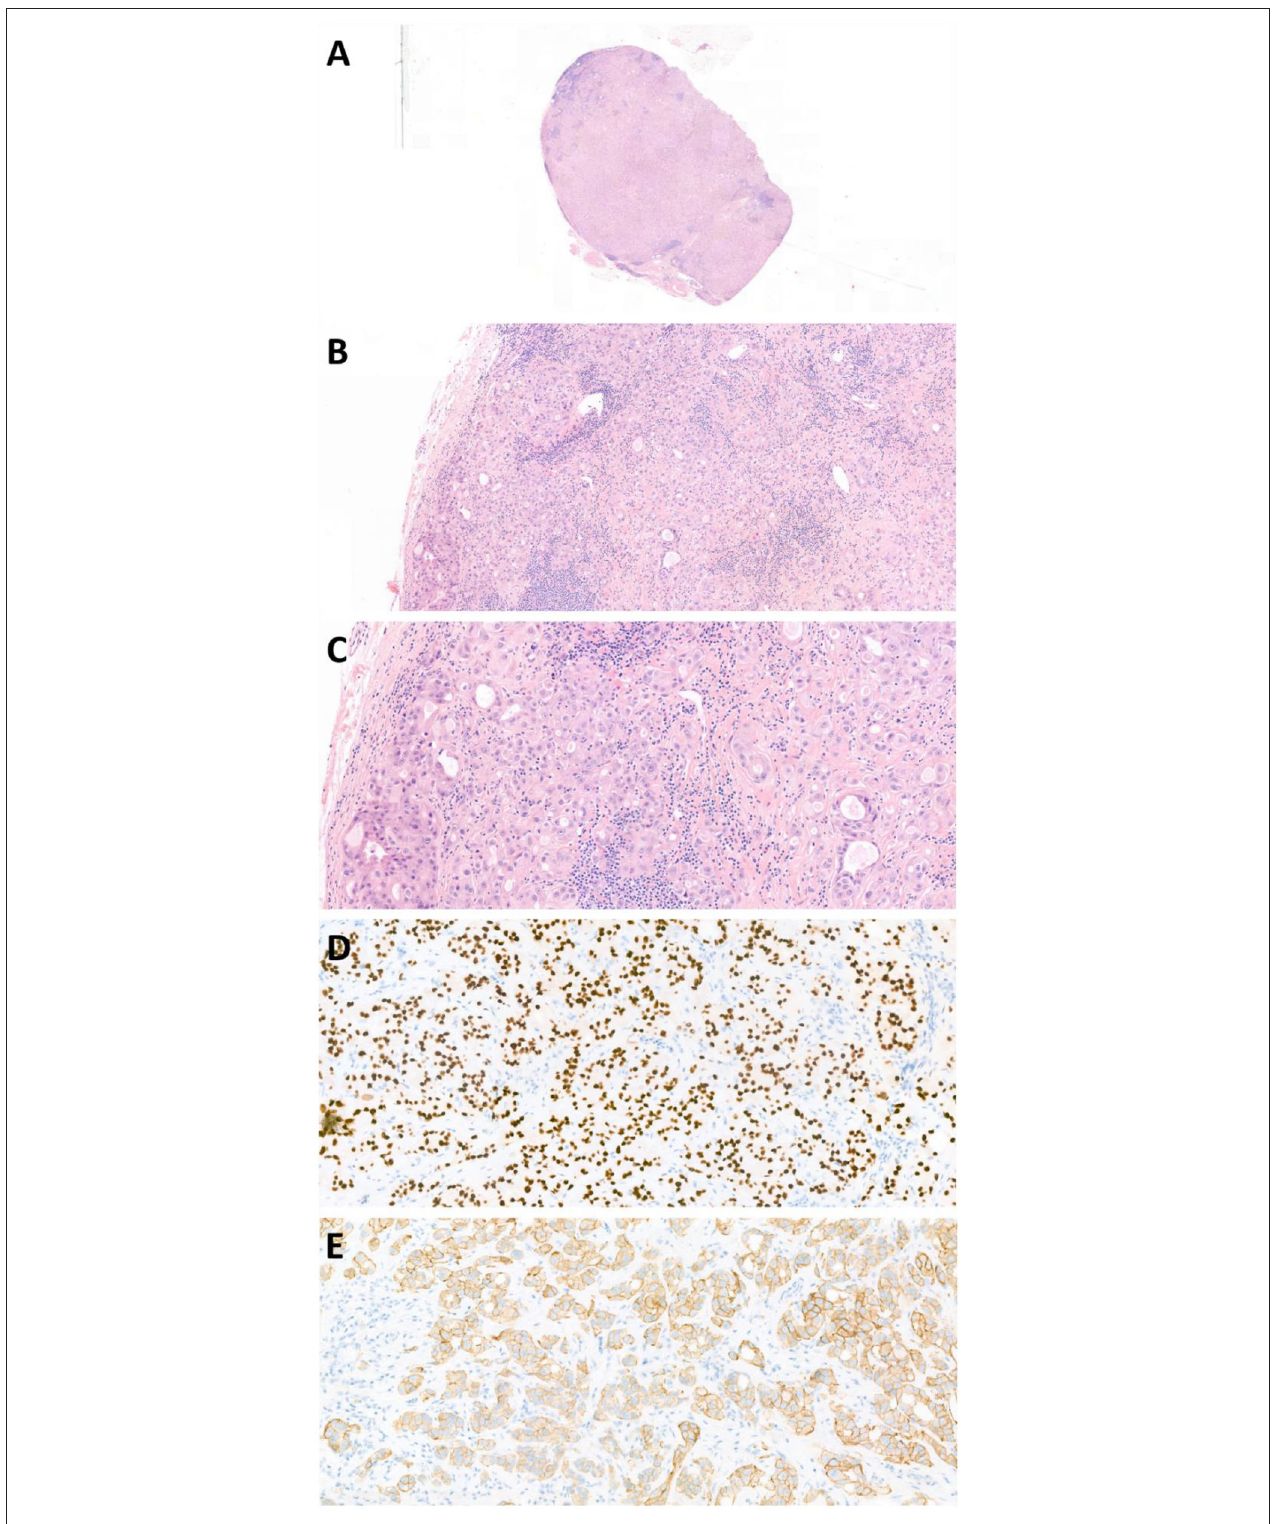
FIGURE 2 | Photomicrographs of case report 1: cervical lymph node containing an SDC metastasis. (A) H&E stain 1X, (B) H&E stain 10X, (C) H&E stain 21X, (D) AR stain 20X, AR441 (BioCare Medical), (E) HER2neu stain 21X, HercepTest (Dako Agilent).